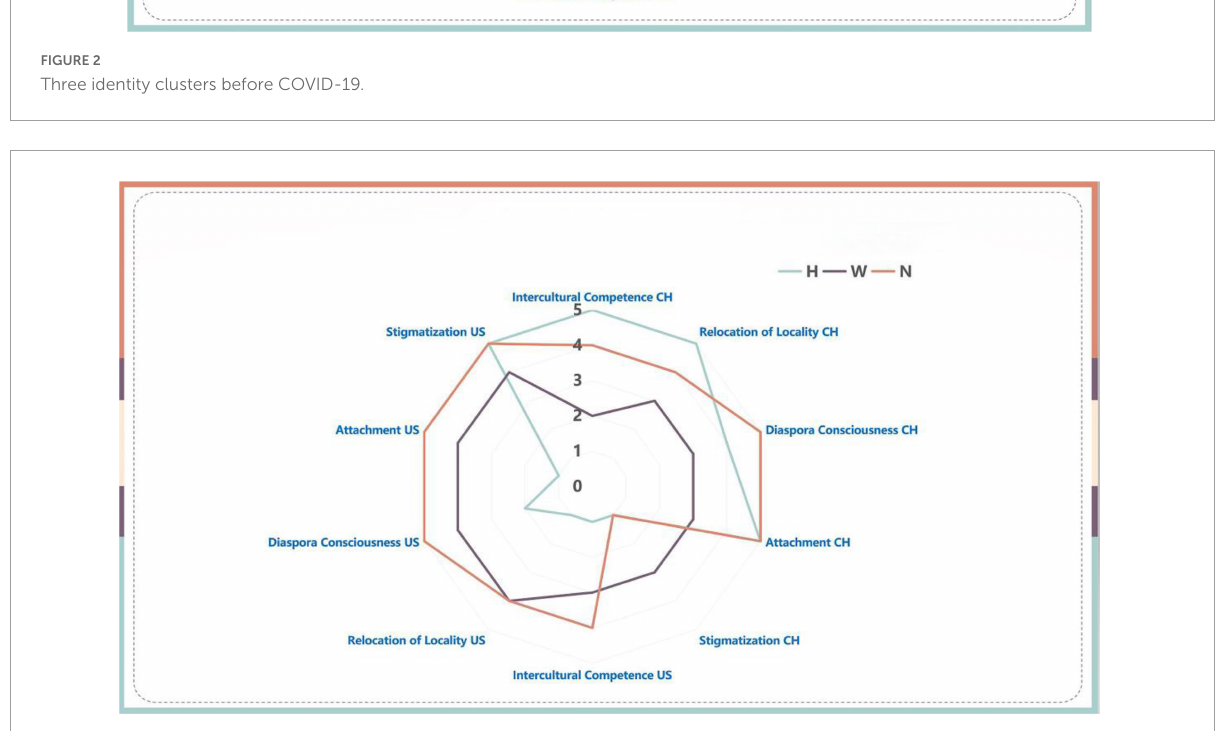
FIGURE3 Identity shifts of the three identity clusters during the